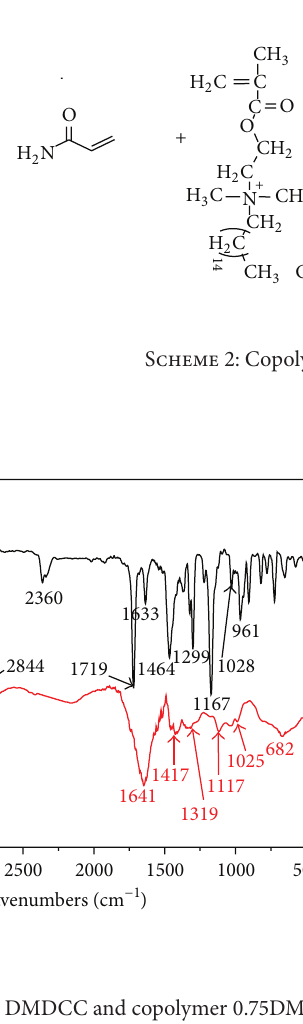
Figure 4: IR spectra of the DMDCC and copolymer 0.75DM12.8.